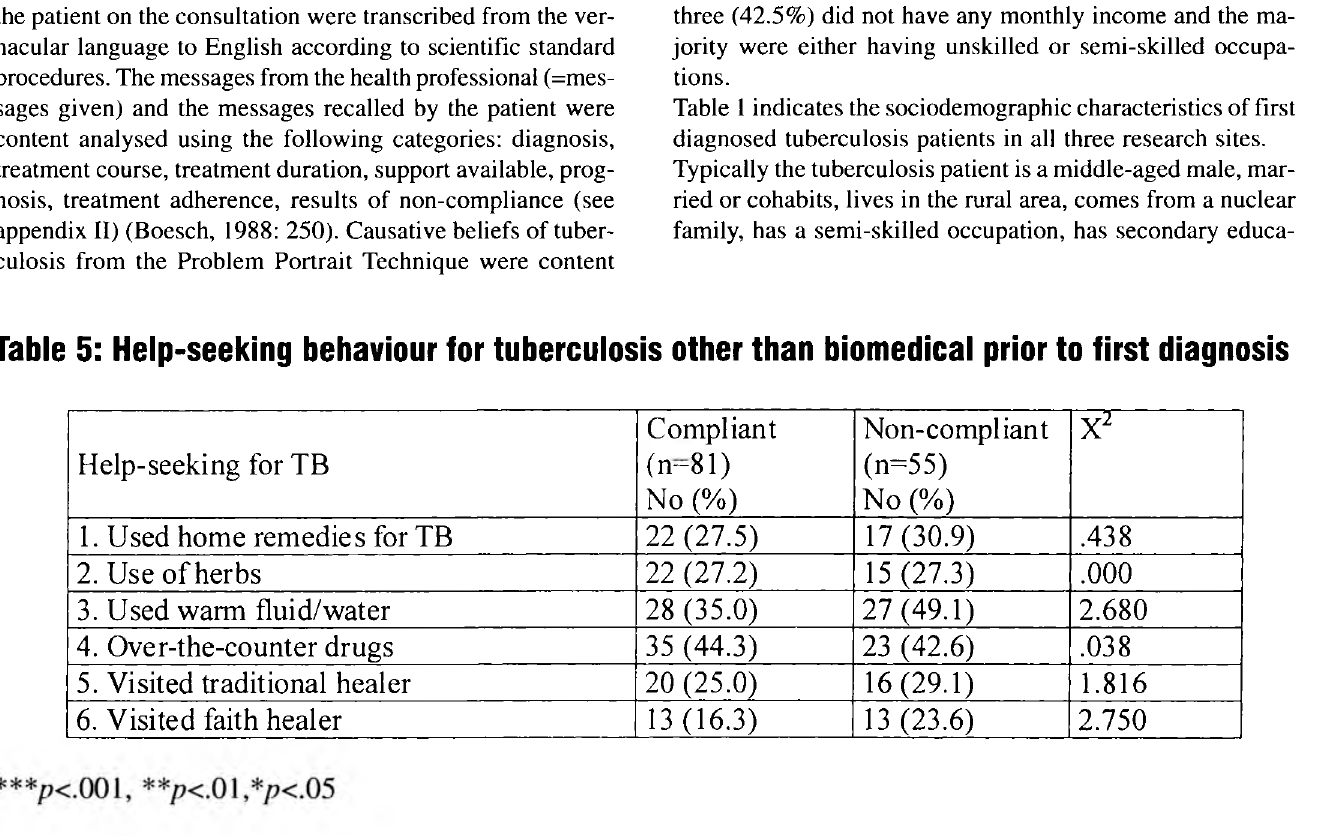
Table 6: Knowledge about transmission of tuberculosis (rated from 1 = strongly agree